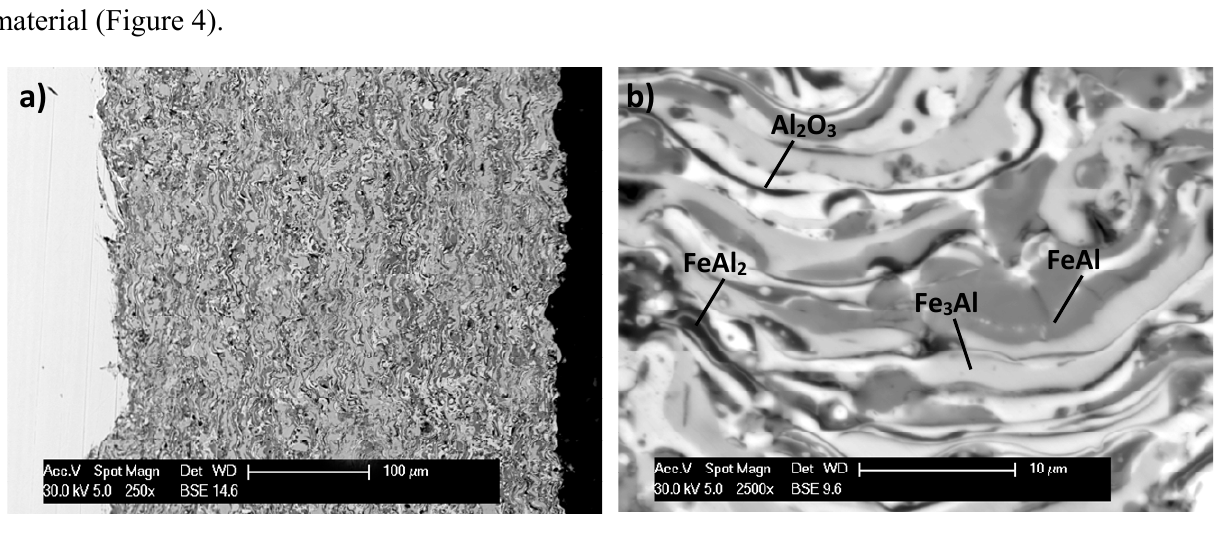
Figure 4. Surface layer of FeAl/1045 steel exhibiting thickness microstructure ( a ) and grain morphology ( b )—on the cross section of the D-gun sprayed Fe-Al type coating deposited in “typical” value of the detonation